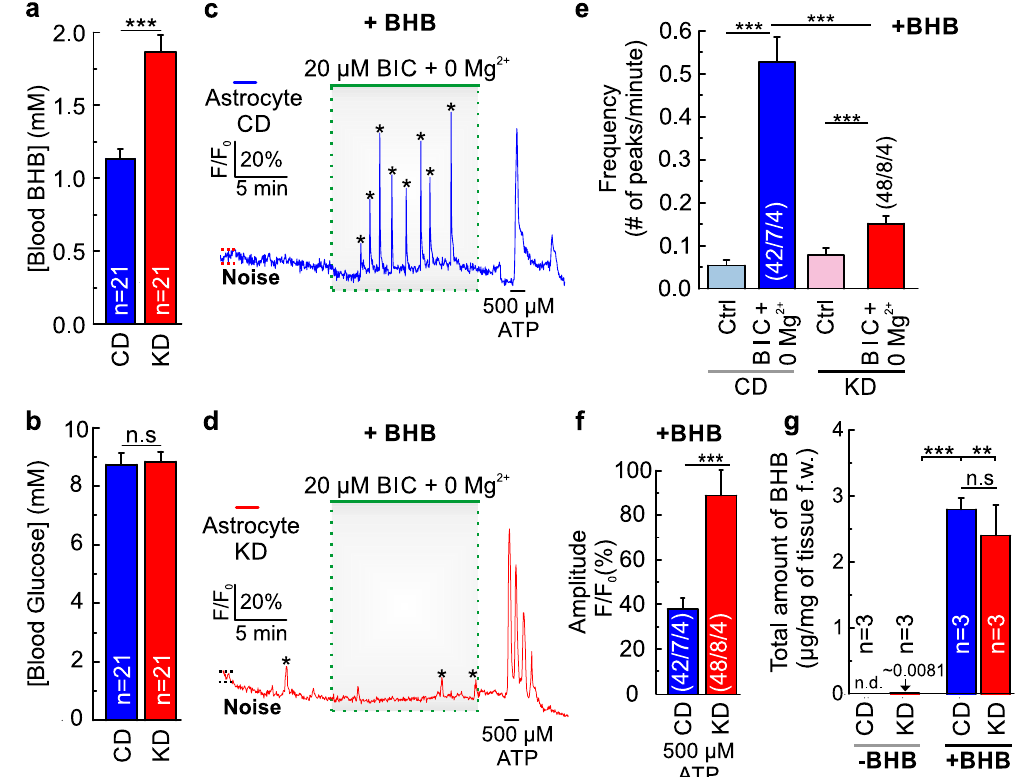
Figure 2. The presence of BHB does not affect epileptiform activity in slices from control mice, but decreases further the induced activity in slices of ketogenic mice. Blood levels of ( a ) BHB and ( b ) glucose in control (blue bars) and ketogenic (red bars) mice. Changes in astrocytic Ca 2 + signals, as induced by epileptiform activity (0 Mg 2 + /BIC) in cortical slices in CO 2 /HCO 3 − -buffer in the presence of BHB, from mice that followed a control ( c ) and a ketogenic diet ( d ). Frequency of the peaks occurred spontaneously (ctrl; light blue and light red bars) and induced by 0 Mg 2 + /BIC in CO 2 /HCO 3 − -buffer in the presence of BHB, in slices from mice that followed control (blue bar) and ketogenic (red bar) diets ( e ). Amplitude of the peaks induced by ATP in astrocytes from control (blue bar) and ketogenic mice (red bar) in the presence of BHB ( f ). Mass spectrometry-based quantification of the total amount of BHB in slices from control (blue bars) and ketogenic (red bars) mice, in the absence and in the presence of BHB ( g ). Statistical values are presented as means ± S.E.M. Significance was tested with paired Student’s t-test. Number of astrocytes/slices/mice used are indicated in the bar